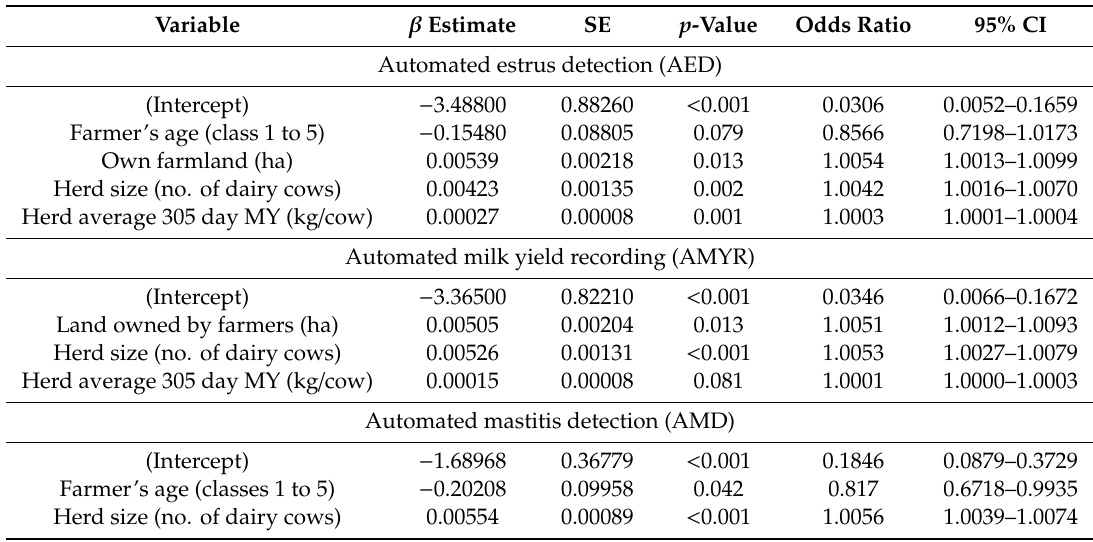
Table 3. Logistic regression output and obtained odds ratios for the prediction of the presence of a tool for automated estrus detection (AED), milk yield recording (AMYR), and mastitis detection (AMD) in the farms, as determined by the analysis of general farm information.